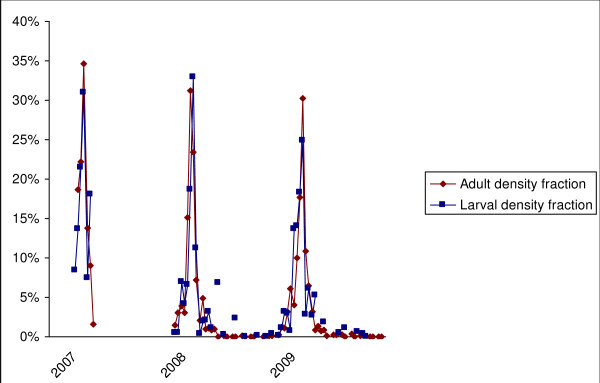
Temporal variations of Anopheles adult density fraction and Anopheles larval density fraction. Data collected in 45 studied areas in Dakar in Sept-Oct 2007 and Jul 2008-April 2010.